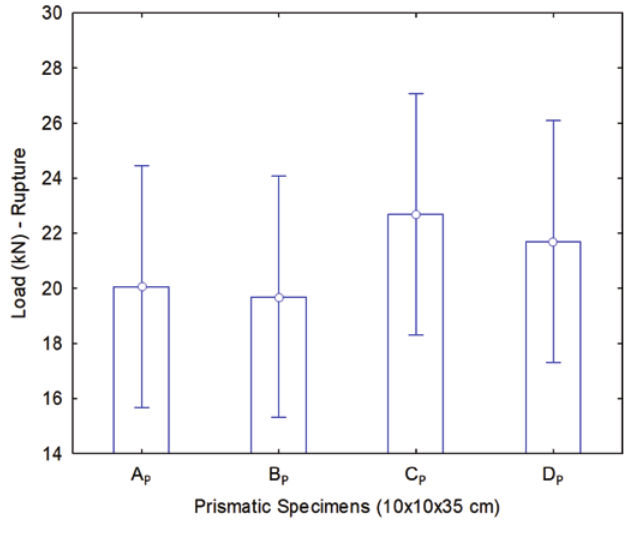
Figure 8 Analysis of the load results on the rupture in prismatic specimens (10 × 10 × 35